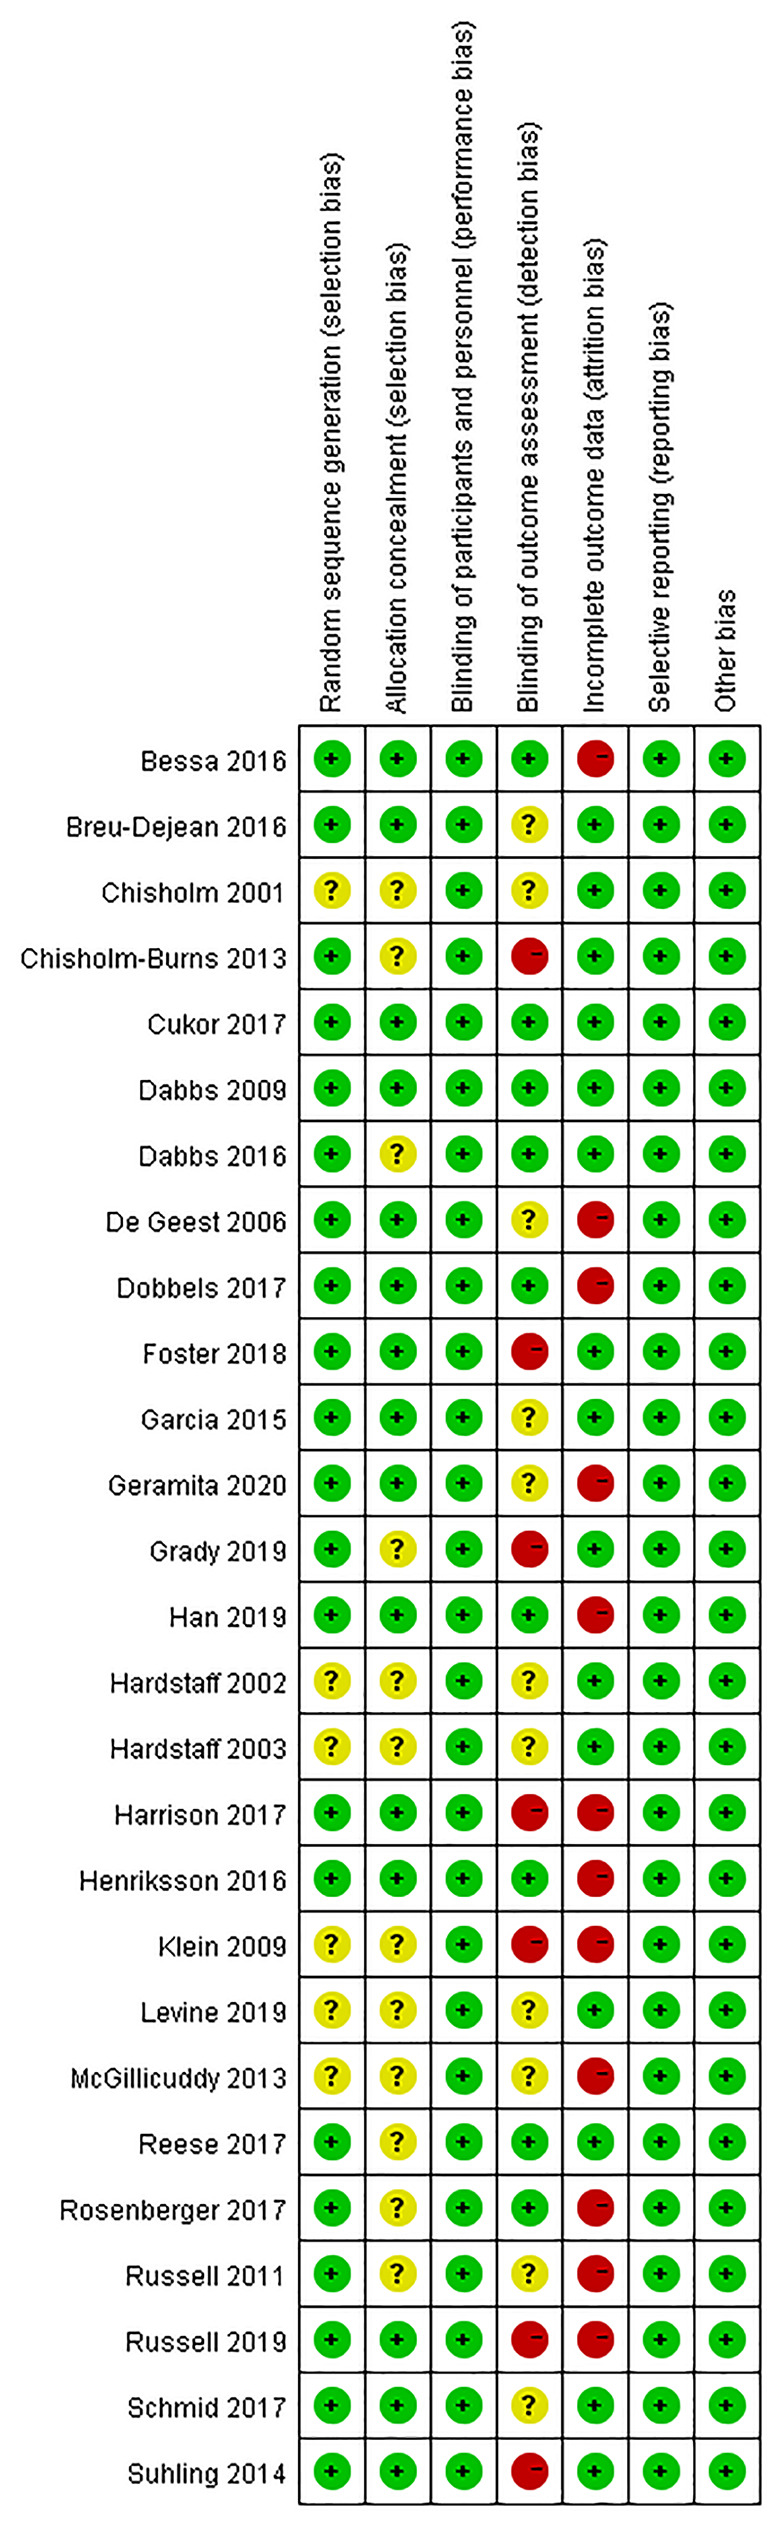
Risk of bias graph.